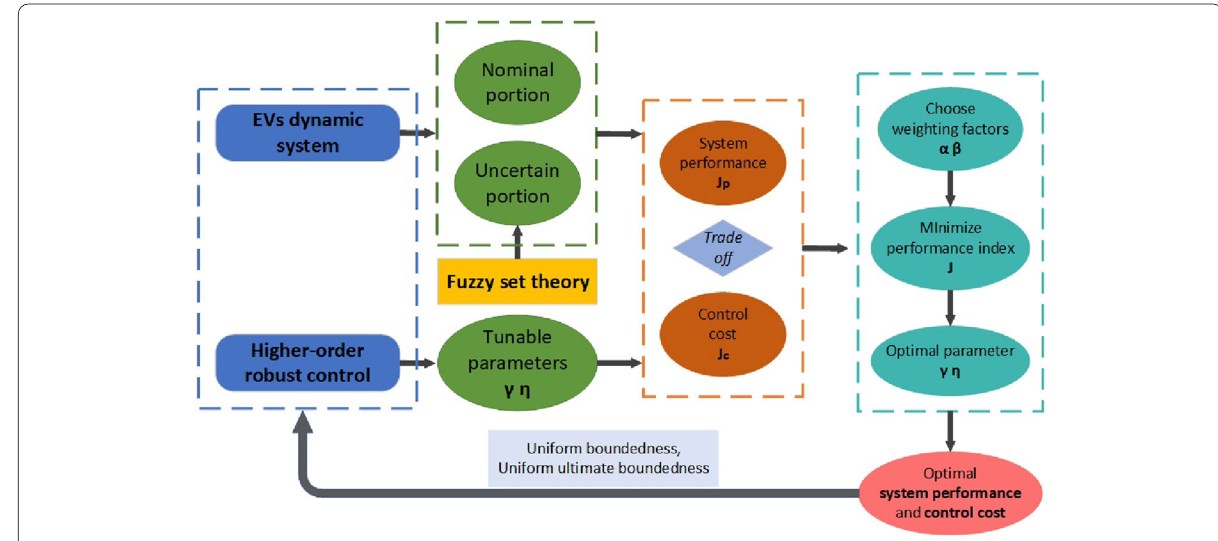
Figure 4 The frame of EVs system and optimal control design